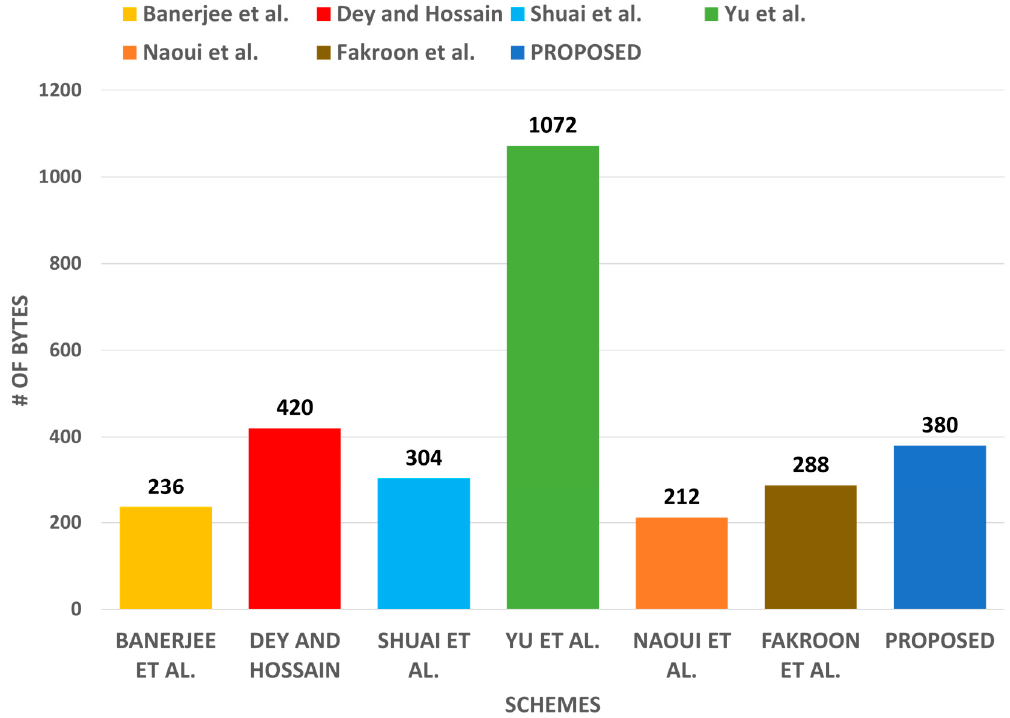
Figure 10. Communication cost comparison.